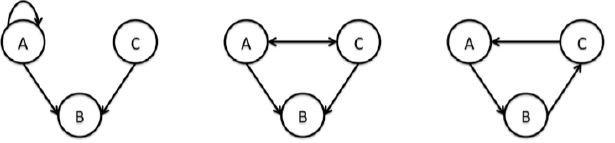
Figure 3. The self-cycle (left), the path-cycle (center) and the regular-cycle